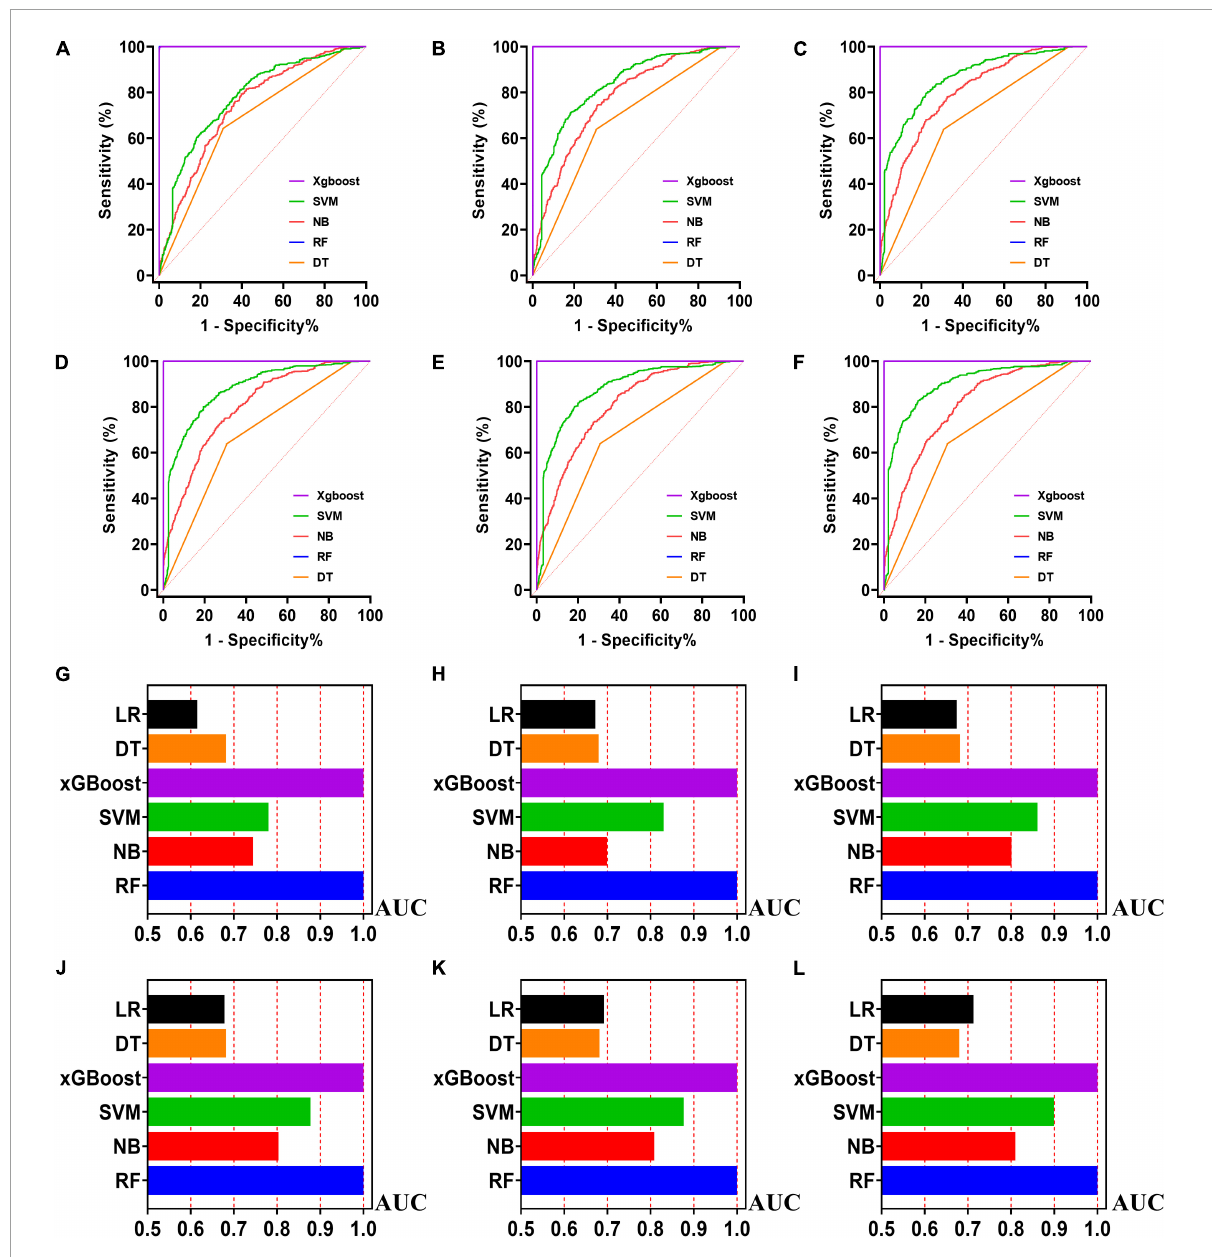
FIGURE4 The ROC curves for machine learning models and the performances of all models in test cohort. The X-axis in 4G-4L represents the AUC values of each model. Top 5 variables (A,G) ; top 10 variables (B,H) ; top 15 variables (C,I) ; top 20 variables (D,J) ; top 25 variables (E,K) ; models for all variables (F,L)